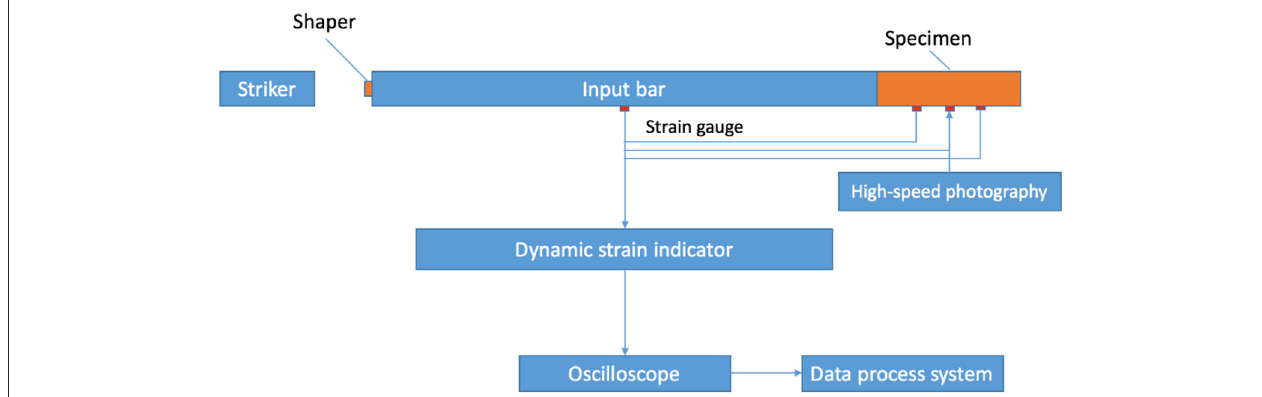
FIGURE 8 | Plan view of the setup of spall test.